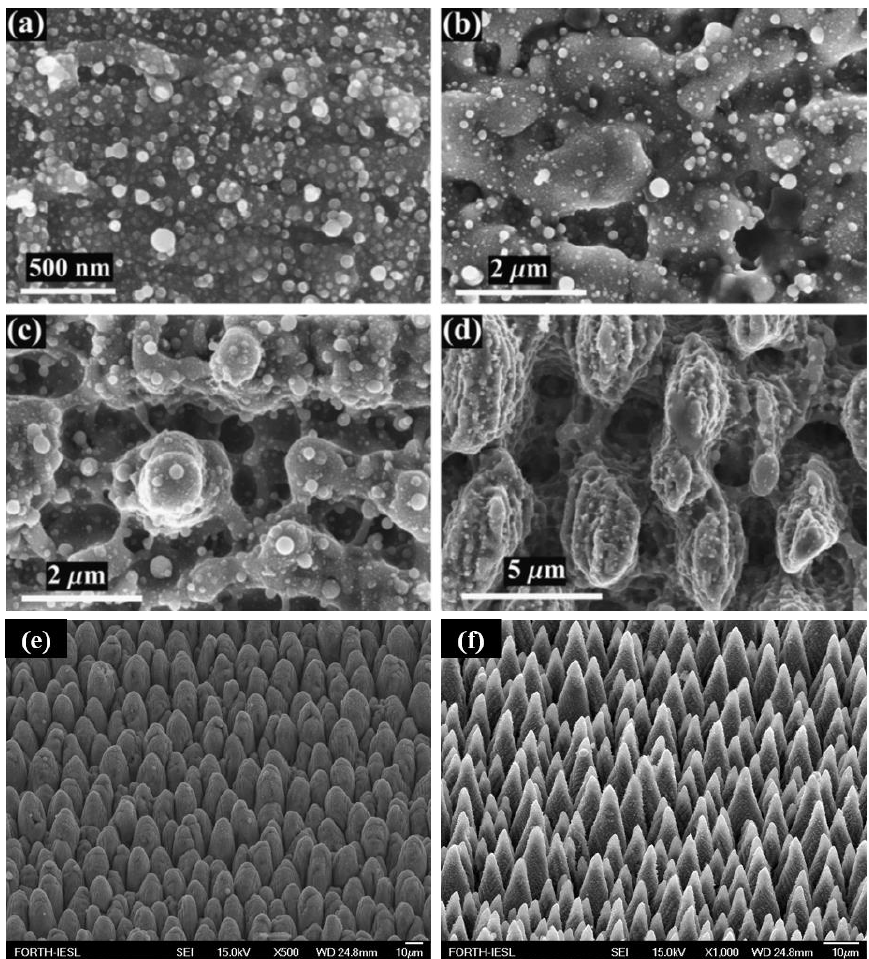
Figure 5. ( a – d ) Titanium sample irradiated with F = 0.35 J/cm 2 ( a ) 1 laser shot, ( b ) 40 laser shots, ( c ) 100 laser shots, and ( d ) 200 laser shots [21]. Reproduced with permission from [21] Elsevier 2007. ( e , f ) Black silicon surfaces obtained upon FS laser processing in air and SF 6 ambient conditions, respectively